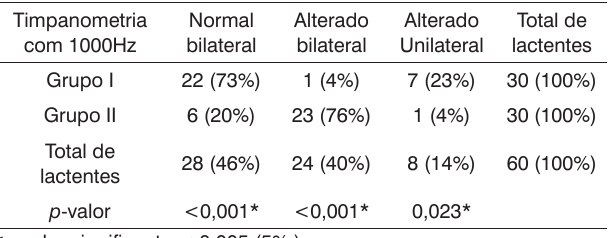
Tabela 6. Tipo de amamentação recebida pelos lactentes nos grupos